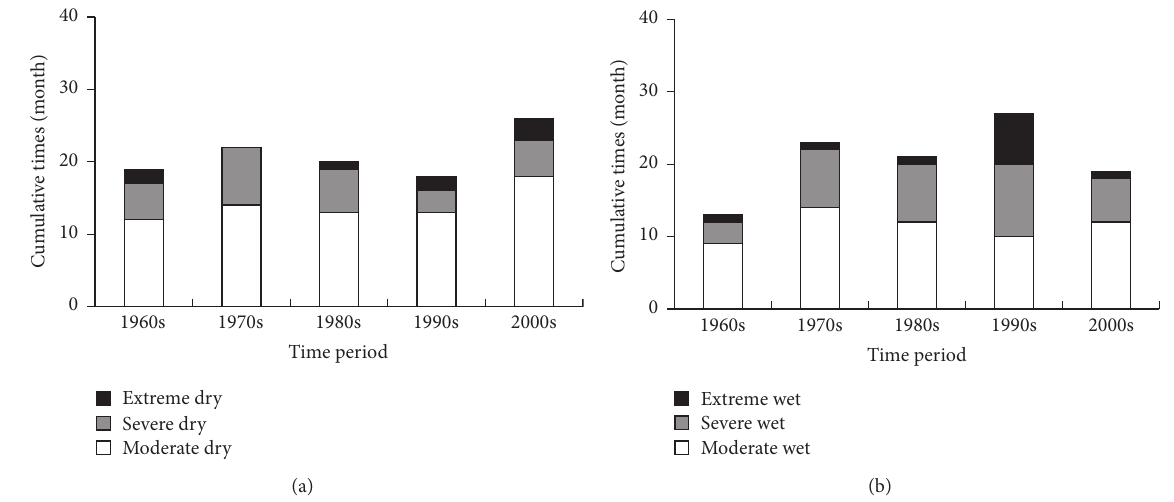
Figure 3: Cumulative times of (a) dry and (b) wet episodes of different categories occurring in the Poyang Lake basin under different